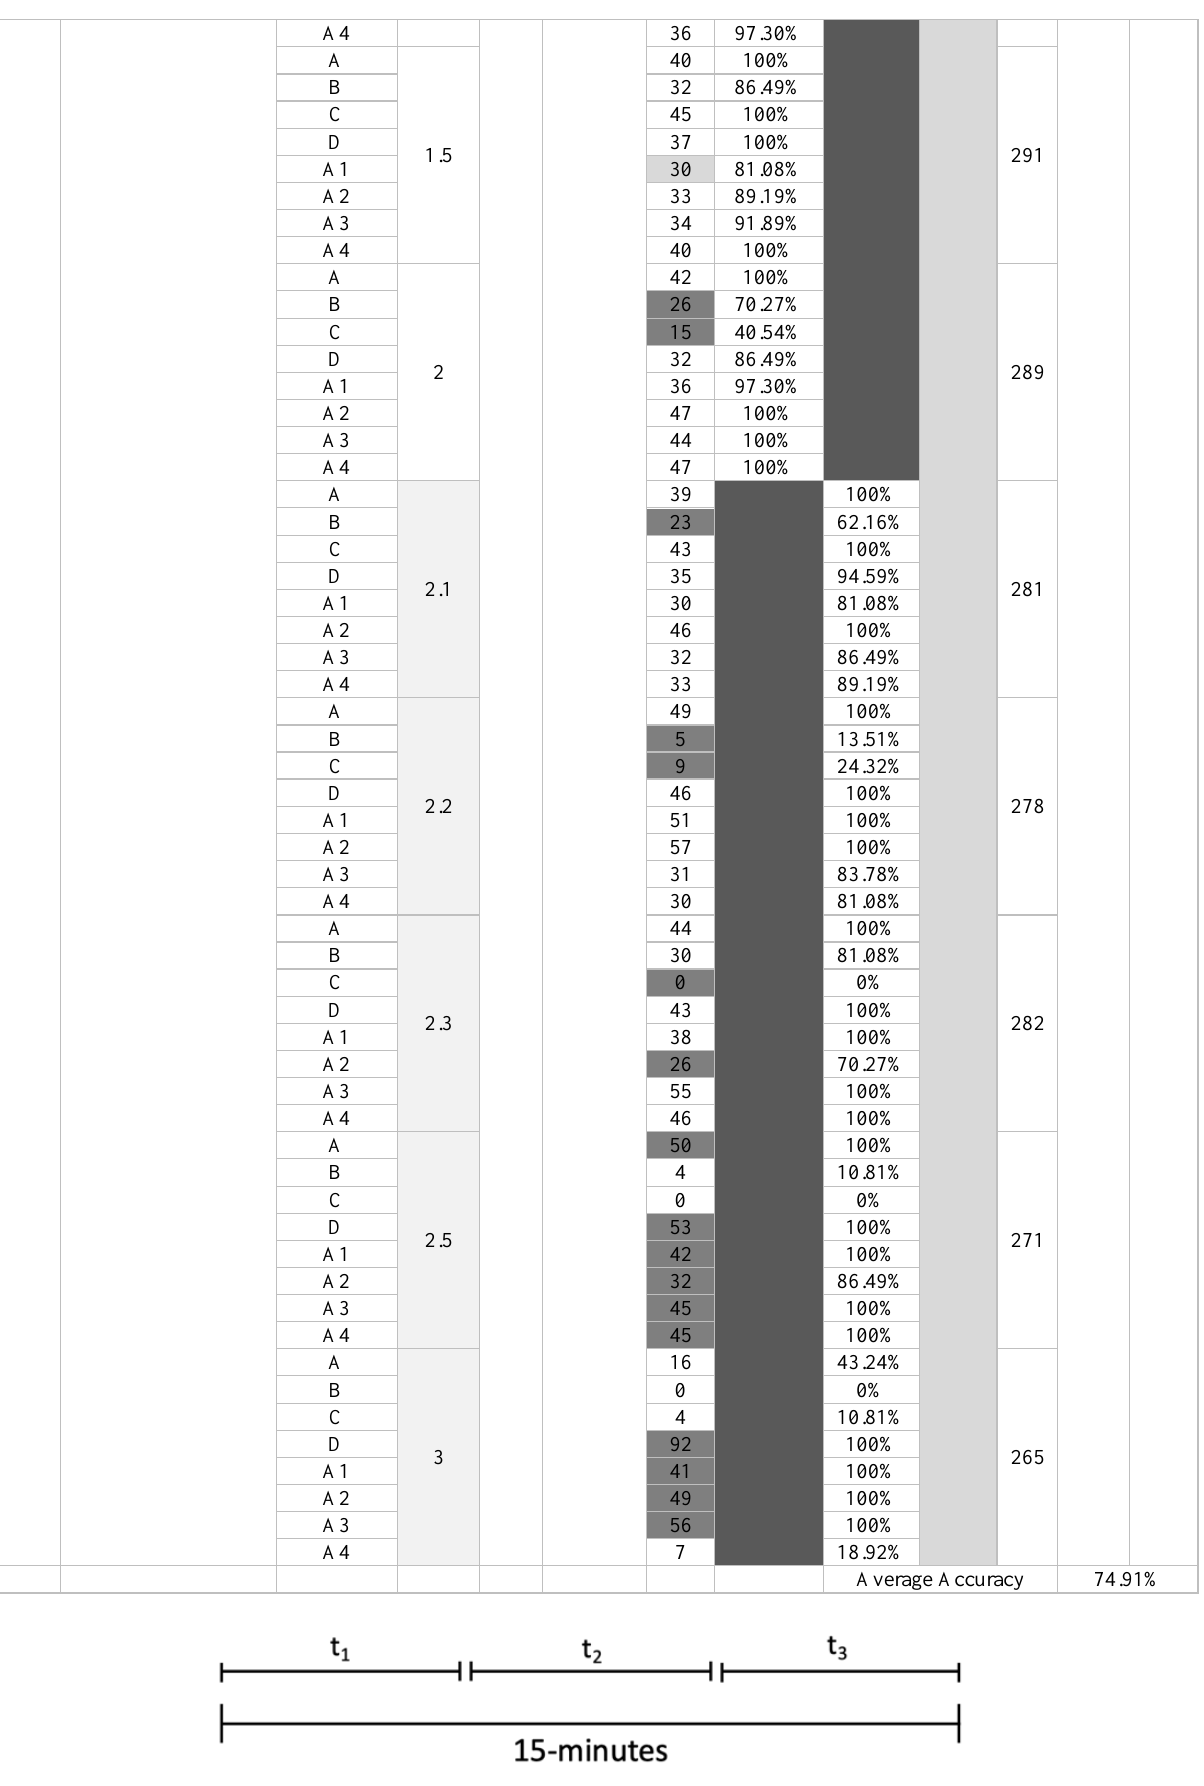
Figure 8. Separation of 15-minutes duration into three-time